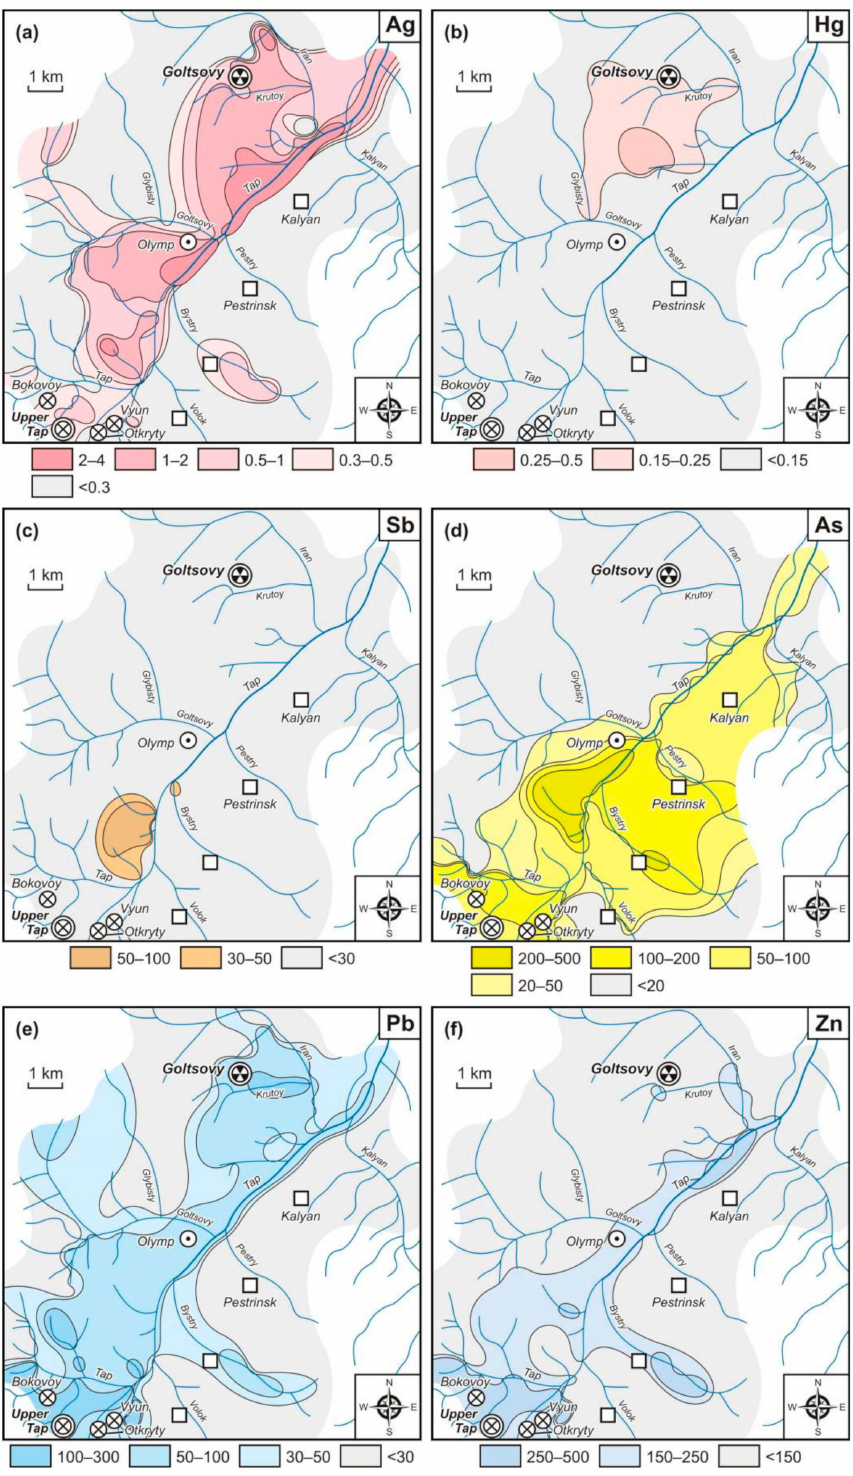
Figure 7. The Pestrinsk SBS (fragment). Exogenous Ag ( a ), Hg ( b ), Sb ( c ), As ( d ), Pb ( e ), and Zn ( f ) AGCFs identified through SSs (survey at a 1:50,000 scale). Here and in Figure 8, the contents of all elements are given in